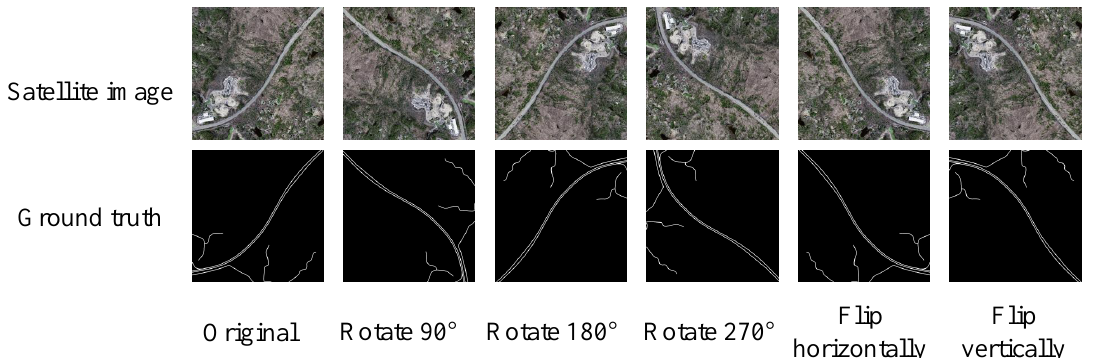
Figure 4. An example of augmenting the training data by rotating and flipping.